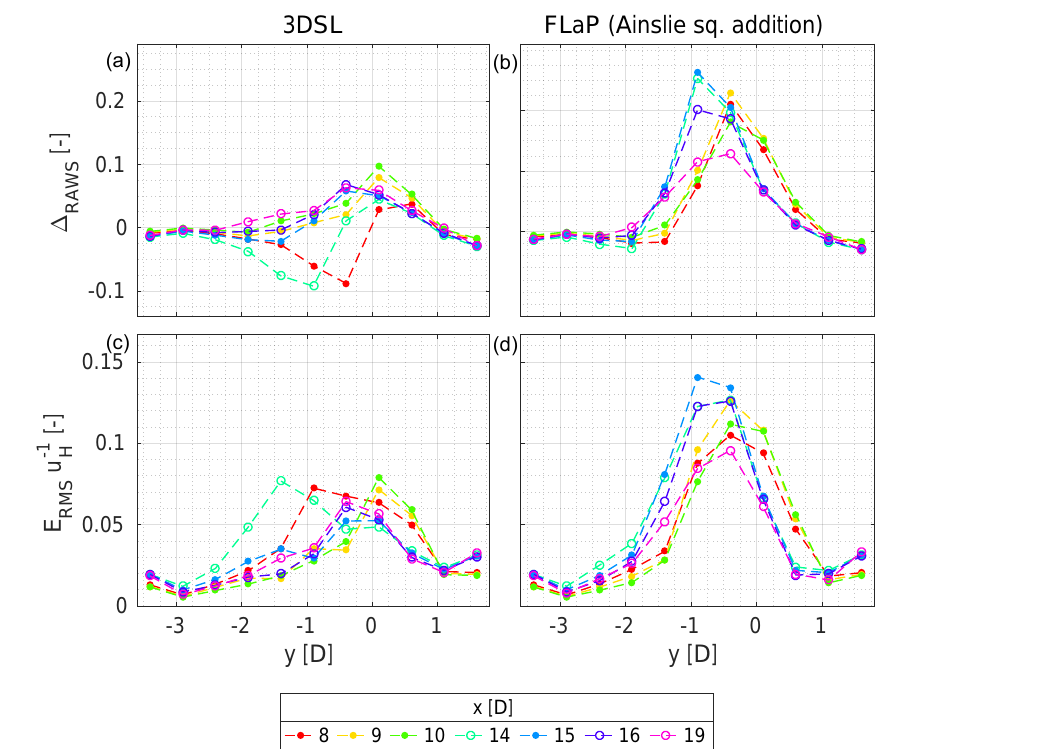
Figure 9. Test case 3 (multiple wakes with 0.5 D lateral separation). Deviation of the rotor-average wind speed (cid:49) RAWS (a, b) and of the root mean square error E RMS (c, d) evaluated in relation to the large-eddy simulation wind field for the simulation with the 3DSL model and with